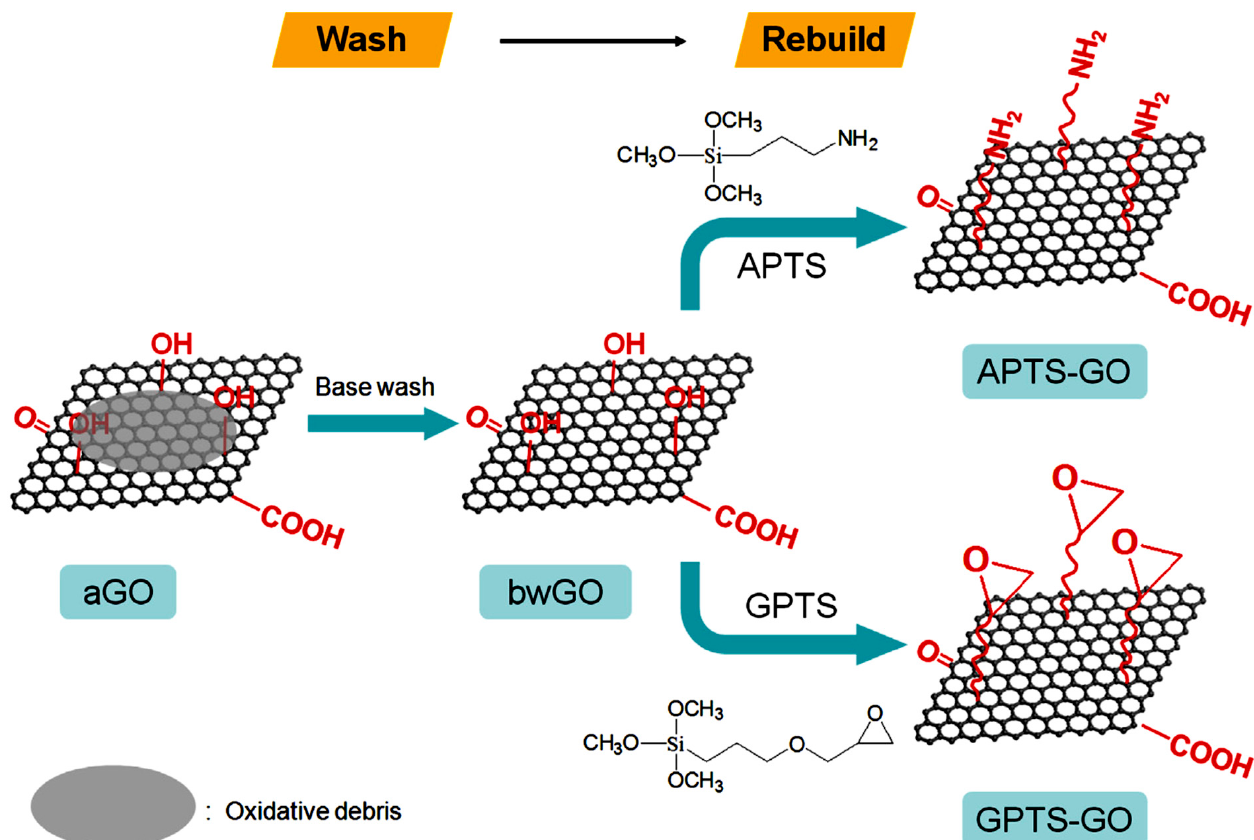
Figure 8. Schematic illustration of the “wash-and-rebuild” process. GO = graphene oxide; APTS = 3-aminopropyltrimethoxysilane; GPTS = 3-glycidoxypropyltrimethoxysilane; APTS-GO = 3-aminopropyltrimethoxysilane-functionalized GO; GPTS-GO = 3-glycidoxypropyltrimethoxysilane-functionalized GO. Reprinted with permission from [114]. 2013, Elsevier.